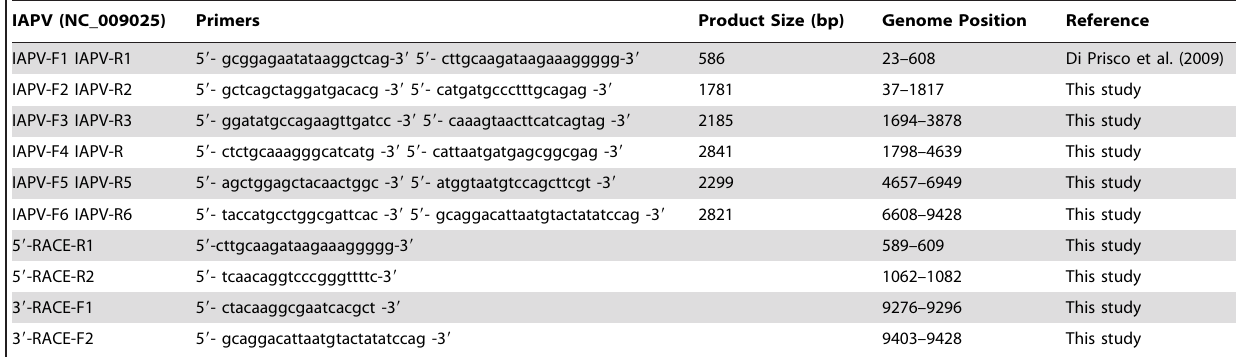
Table 1. IAPV primers used in the